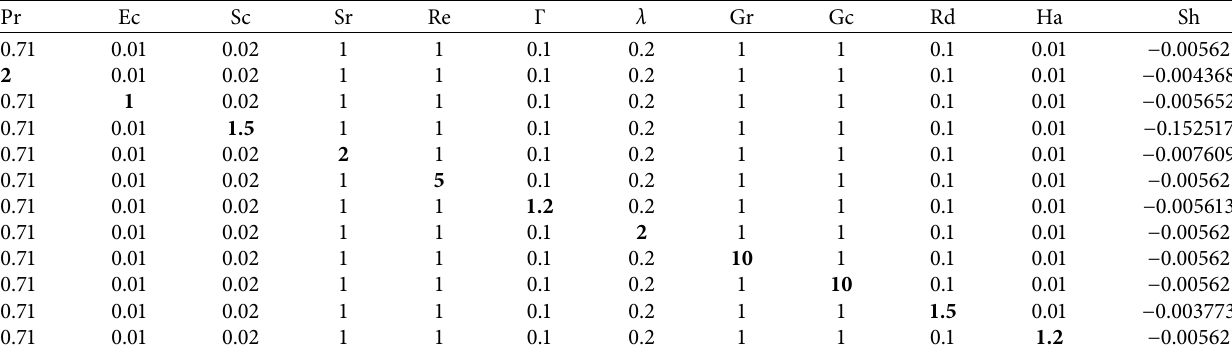
Table 3: Sherwood number for various values of parameters.